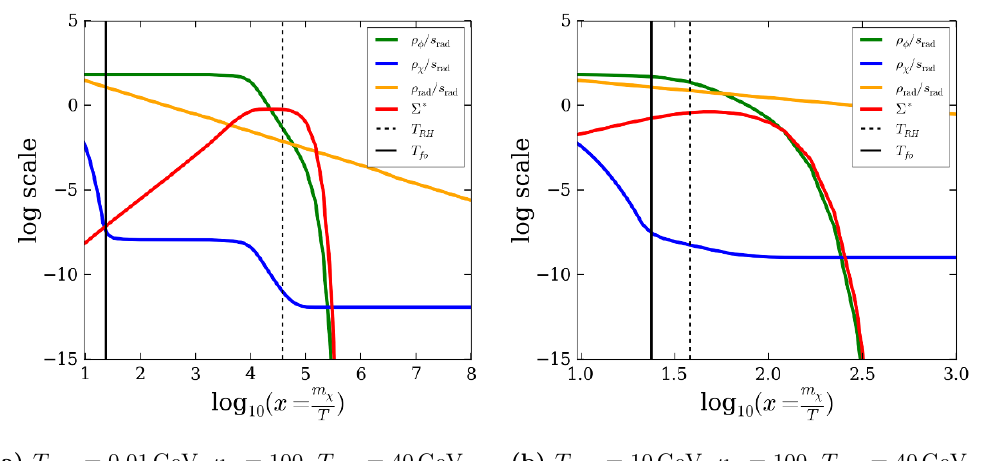
Figure 3. The evolution of the scalar (cid:12)eld, neutralino and radiation densities normalised to the radiation entropy density, and of the injection of entropy e (cid:6) (cid:3) , as a function of x = m (cid:31) =T . T that changes slightly at T (cid:24) 150 MeV to a slope 1.5. This transition is the RH RH